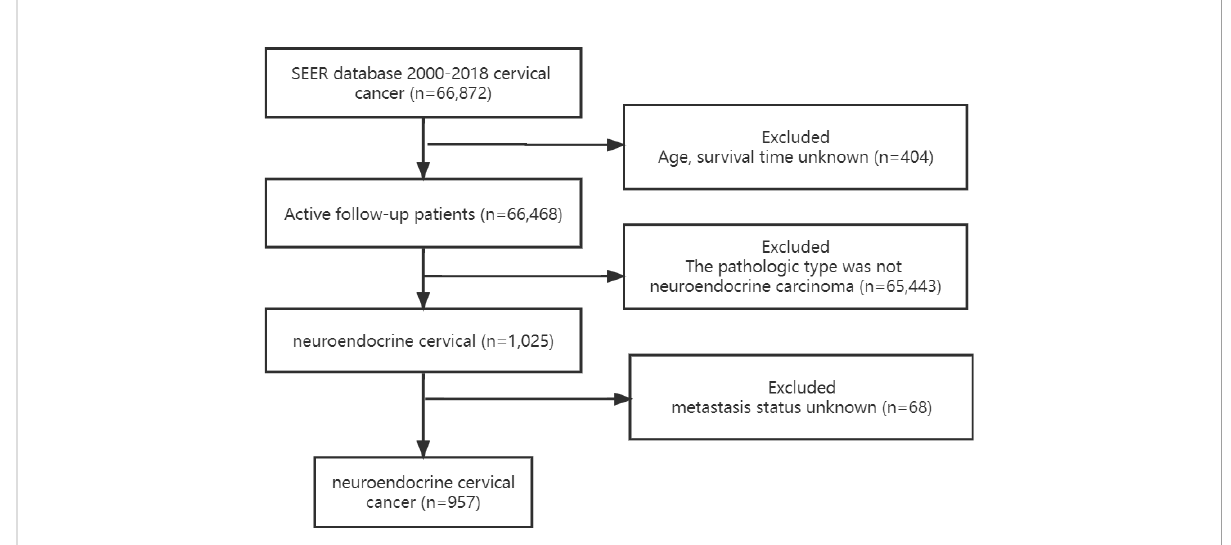
FIGURE 1 Flowchart of the neuroendocrine cervical cancer patient ’ s